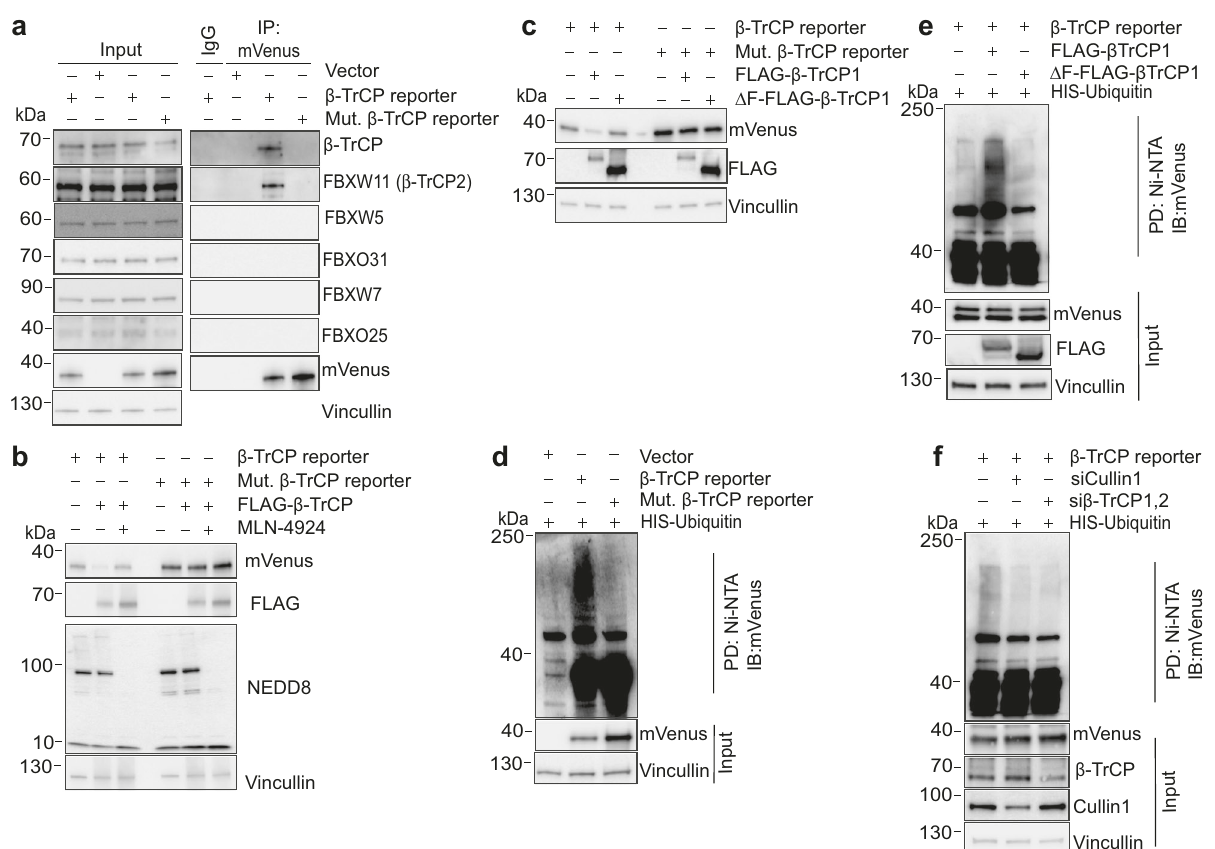
Fig. 2 | β -TrCP speci fi cally binds to and ubiquitinates the β -TrCP reporter. a HEK-293Tcellsweretransfectedasindicatedwithemptyvector, β -TrCPreporter, ormutant β -TrCPreporter.Transfected cellsweretreatedwith3 μ MMLN-4924for the 6h before collection. Whole-cell extracts were immunoprecipitated with the indicated antibody followed by immunoblotting with the indicated antibody. Representative blot from n =3 experiments. b HEK-293T cells were transfected as indicated. Cells were treated either with DMSO or MLN-4924 (3 μ M) for 6h before collection. Cells were harvested and whole-cell protein extracts were immuno- blotted for indicated antibodies. Representative blot from n =3 experiments. c HEK-293T cells were transfected as indicated. Cells were harvested 48h after transfectionandwhole-cellproteinextractswereimmunoblottedfortheindicated antibodies. Representative blot from n =3 experiments. d HEK-293T cells were transfectedasindicated.TransfectedcellswerethentreatedwithMG132(5 µ